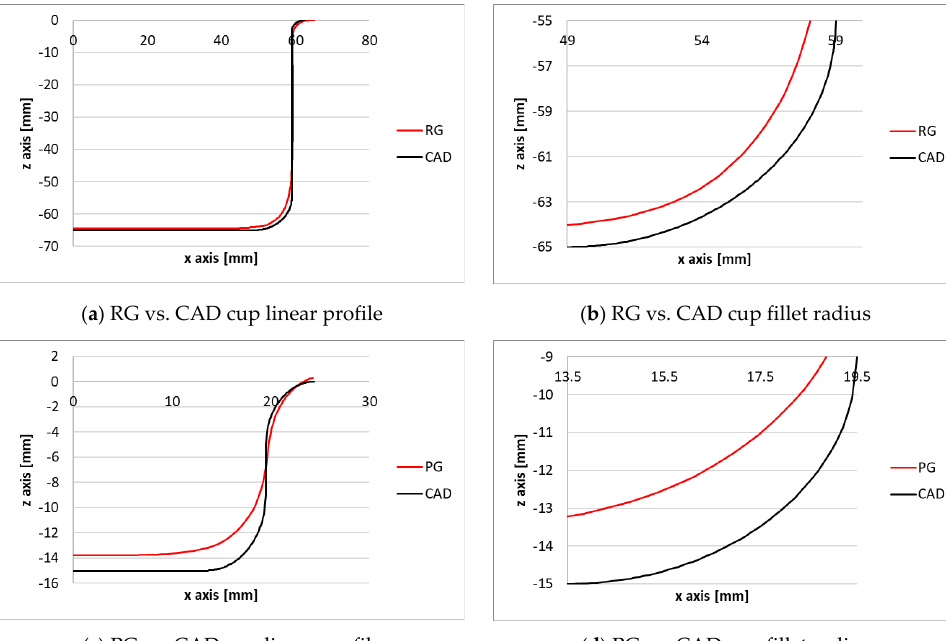
Figure 4. Cups produced with RG (left) and PG (right) and related punches.